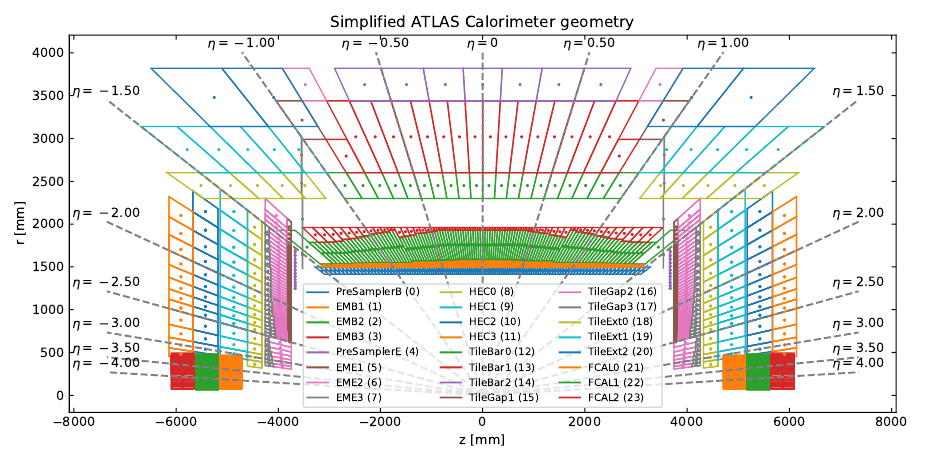
Figure 3. Visualization of the ATLAS calorimeter readout geometry. The three subsystems, Tile, Liquid Argon and the Forward calorimeters, are shown.